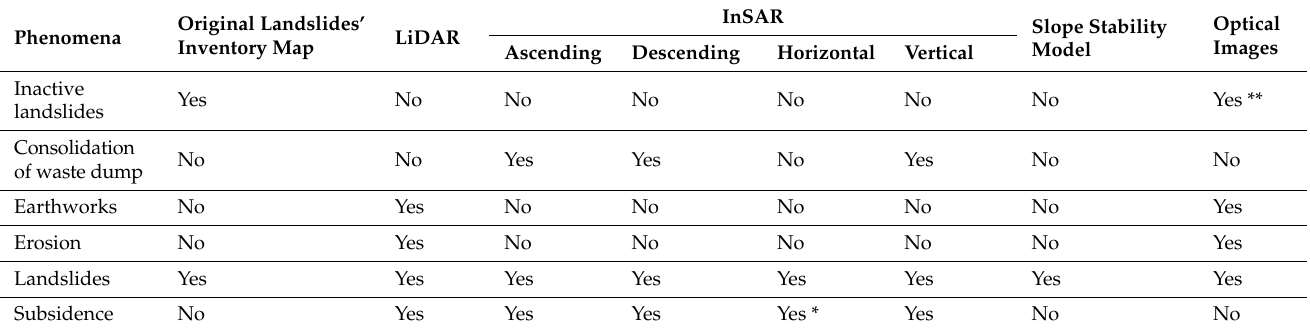
Table 2. The ability of the different remote sensing techniques and the slope stability model to detect different